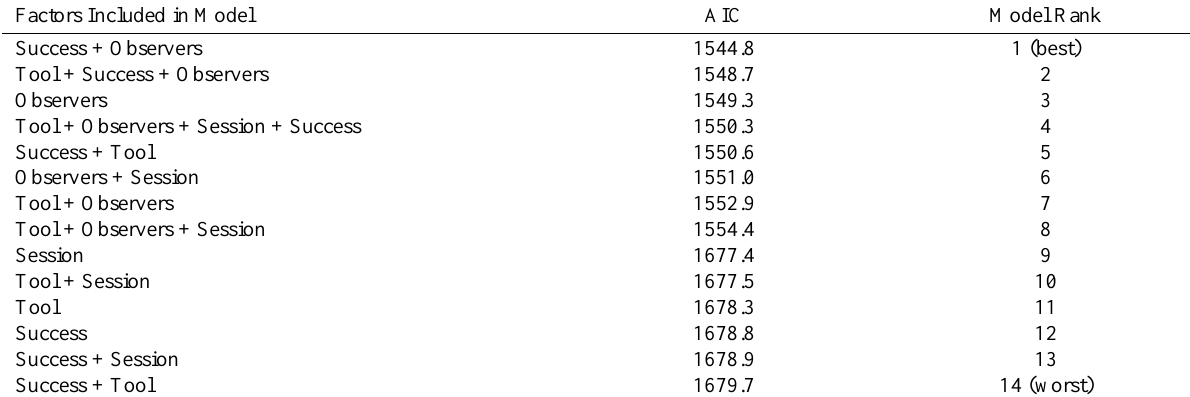
Mixed Effects Logistic Regression Models and Associated AIC Values, for the Models Predicting Switching Holes Factors Included in